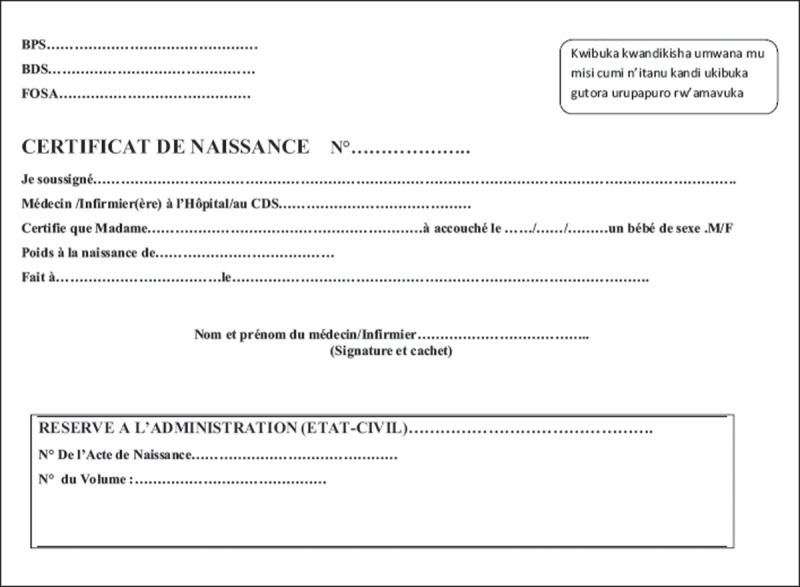
Page for notification of birth in the MCH handbook.